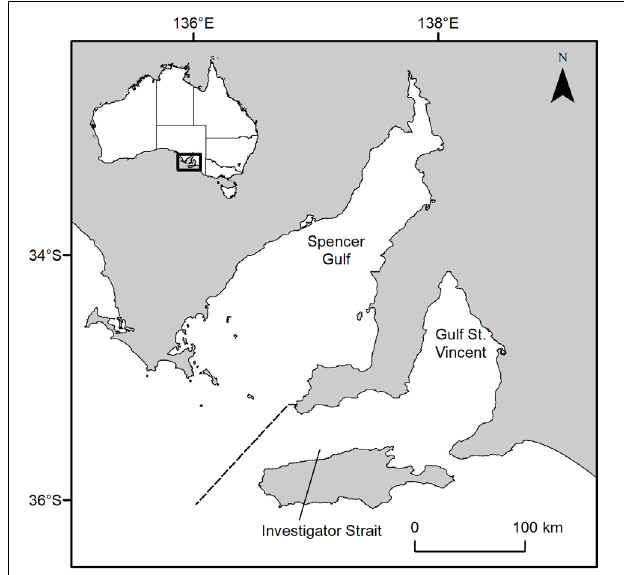
FIGURE 1 | Map of South Australia’s gulf systems. The dashed line separates Spencer Gulf and Gulf St Vincent. Inset, map of Australia showing the study area along the southern